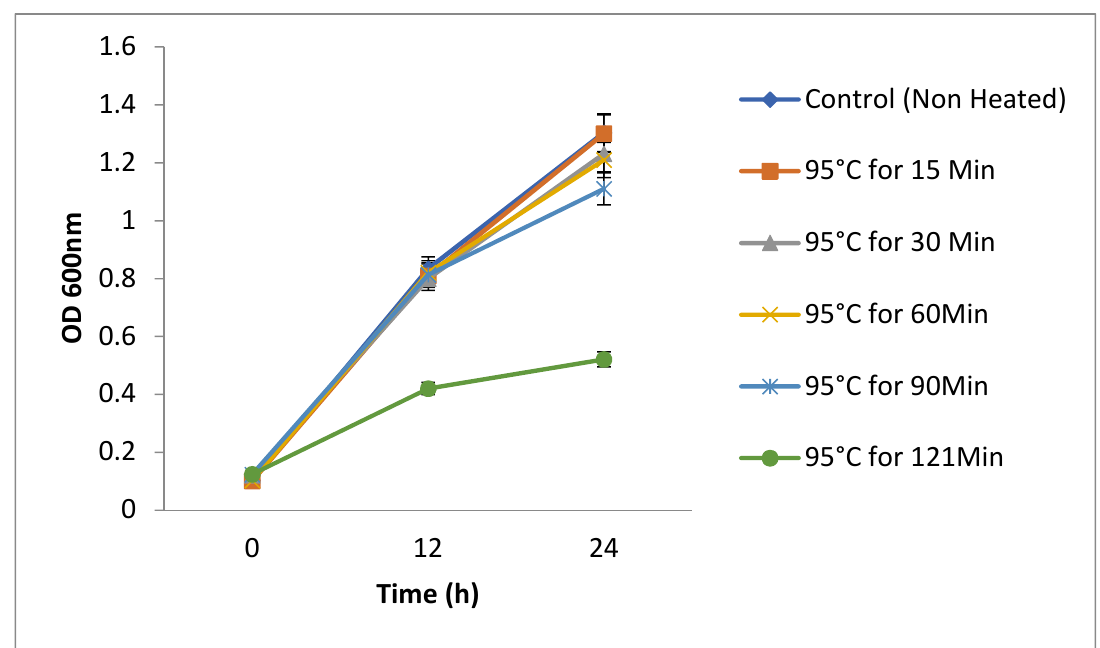
Figure 5. Heat Stability of yeast cells S. boulardii strains (KT000032) and post-growth efficiency with different time duration at 600